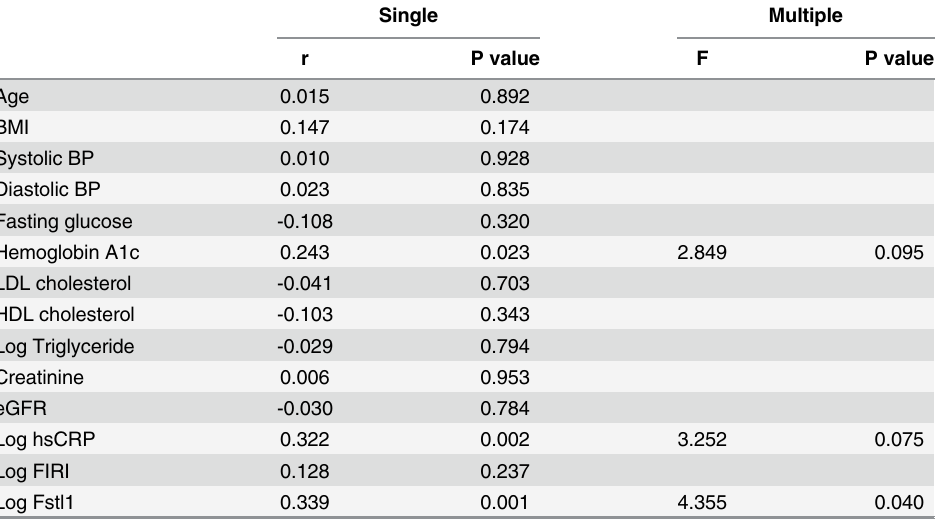
Table 4. Correlation with dROMs